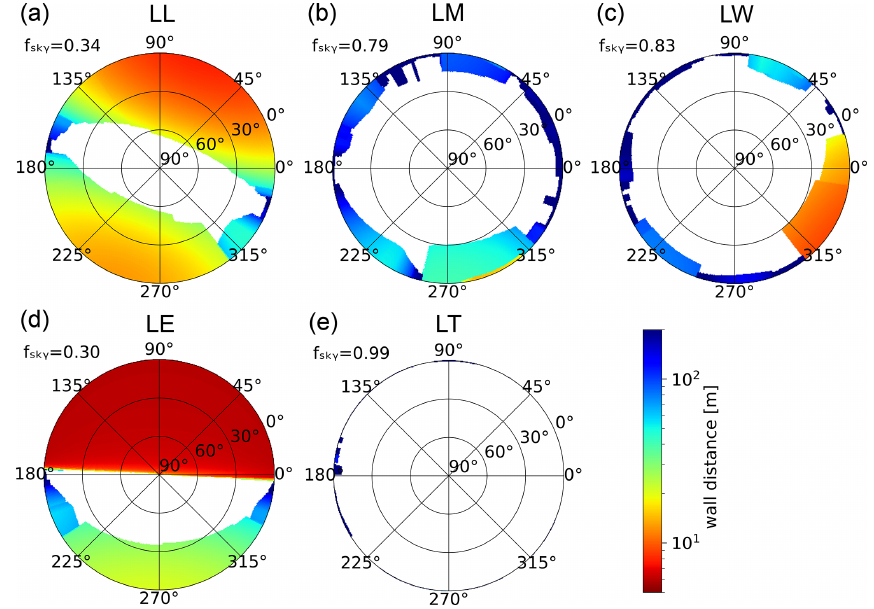
Figure 3. Simulated view on surrounding buildings in spherical coordinates at the exact 3-D locations of the inlets for the stations (a) LL, (b) LC, (c) LW, (d) LE, and (e) LT. The colors indicate the distance of instrument inlets to building walls, while visible sky is shaded in white. Additionally, the sky-view factors f sky are computed as the fraction of the solid angle of the hemisphere not blocked by buildings.